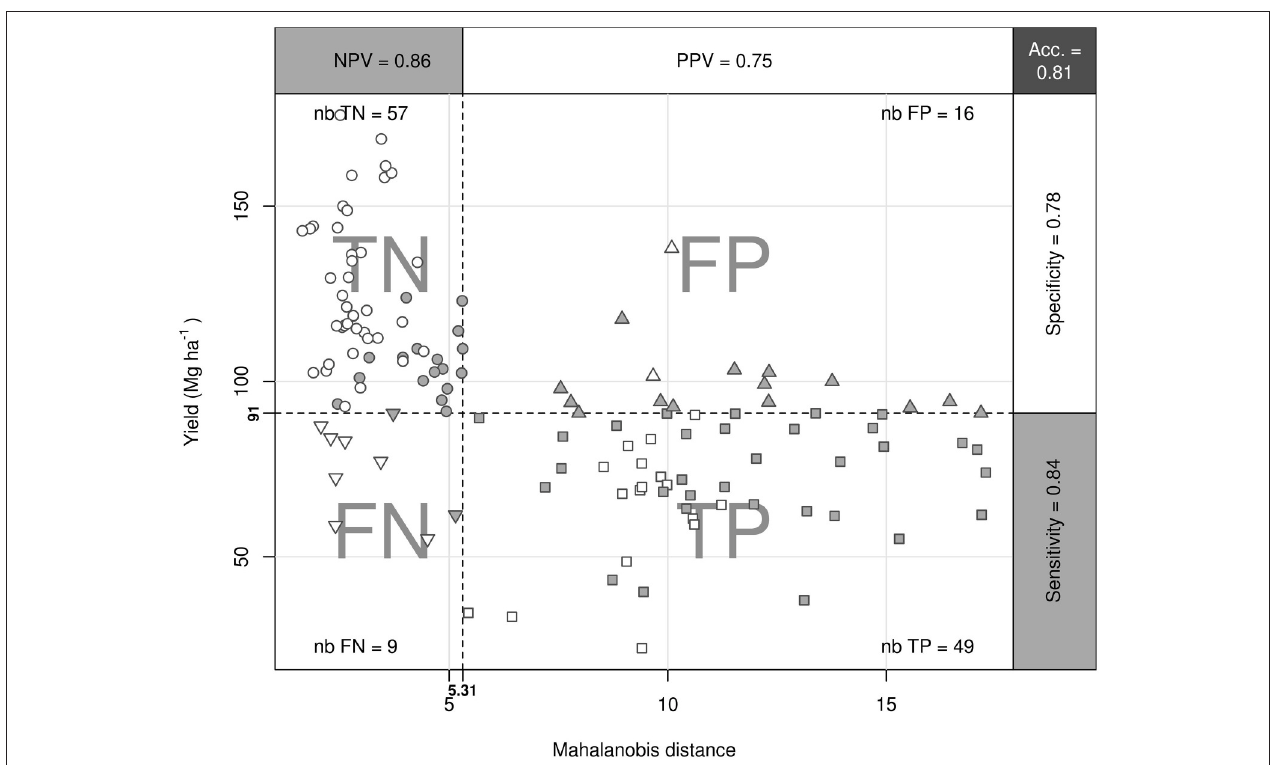
FIGURE 3 | Cate–Nelson partitioning of tomato dataset. Data were partitioned into true negative (TN), false negative (FN), false positive (FP), and true positive (TP) specimens (nb = number). Empty and filled dots represent experimental data and survey data, respectively. Performance indices are the negative predictive value (NPV), positive predictive value (PPV), accuracy (Acc), specificity, and sensitivity.